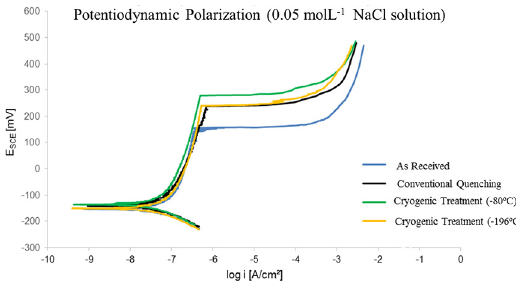
polarization curves, including the corrosion potential (E ) corr and corrosion current (I ) obtained by Tafel extrapolation corr using Nova® software, pitting potential (E ), as well as the pit passivation potential range (∆E ). The latter can be read pass directly on the polarization curve, or calculated from the subtraction of E from E . corr pit